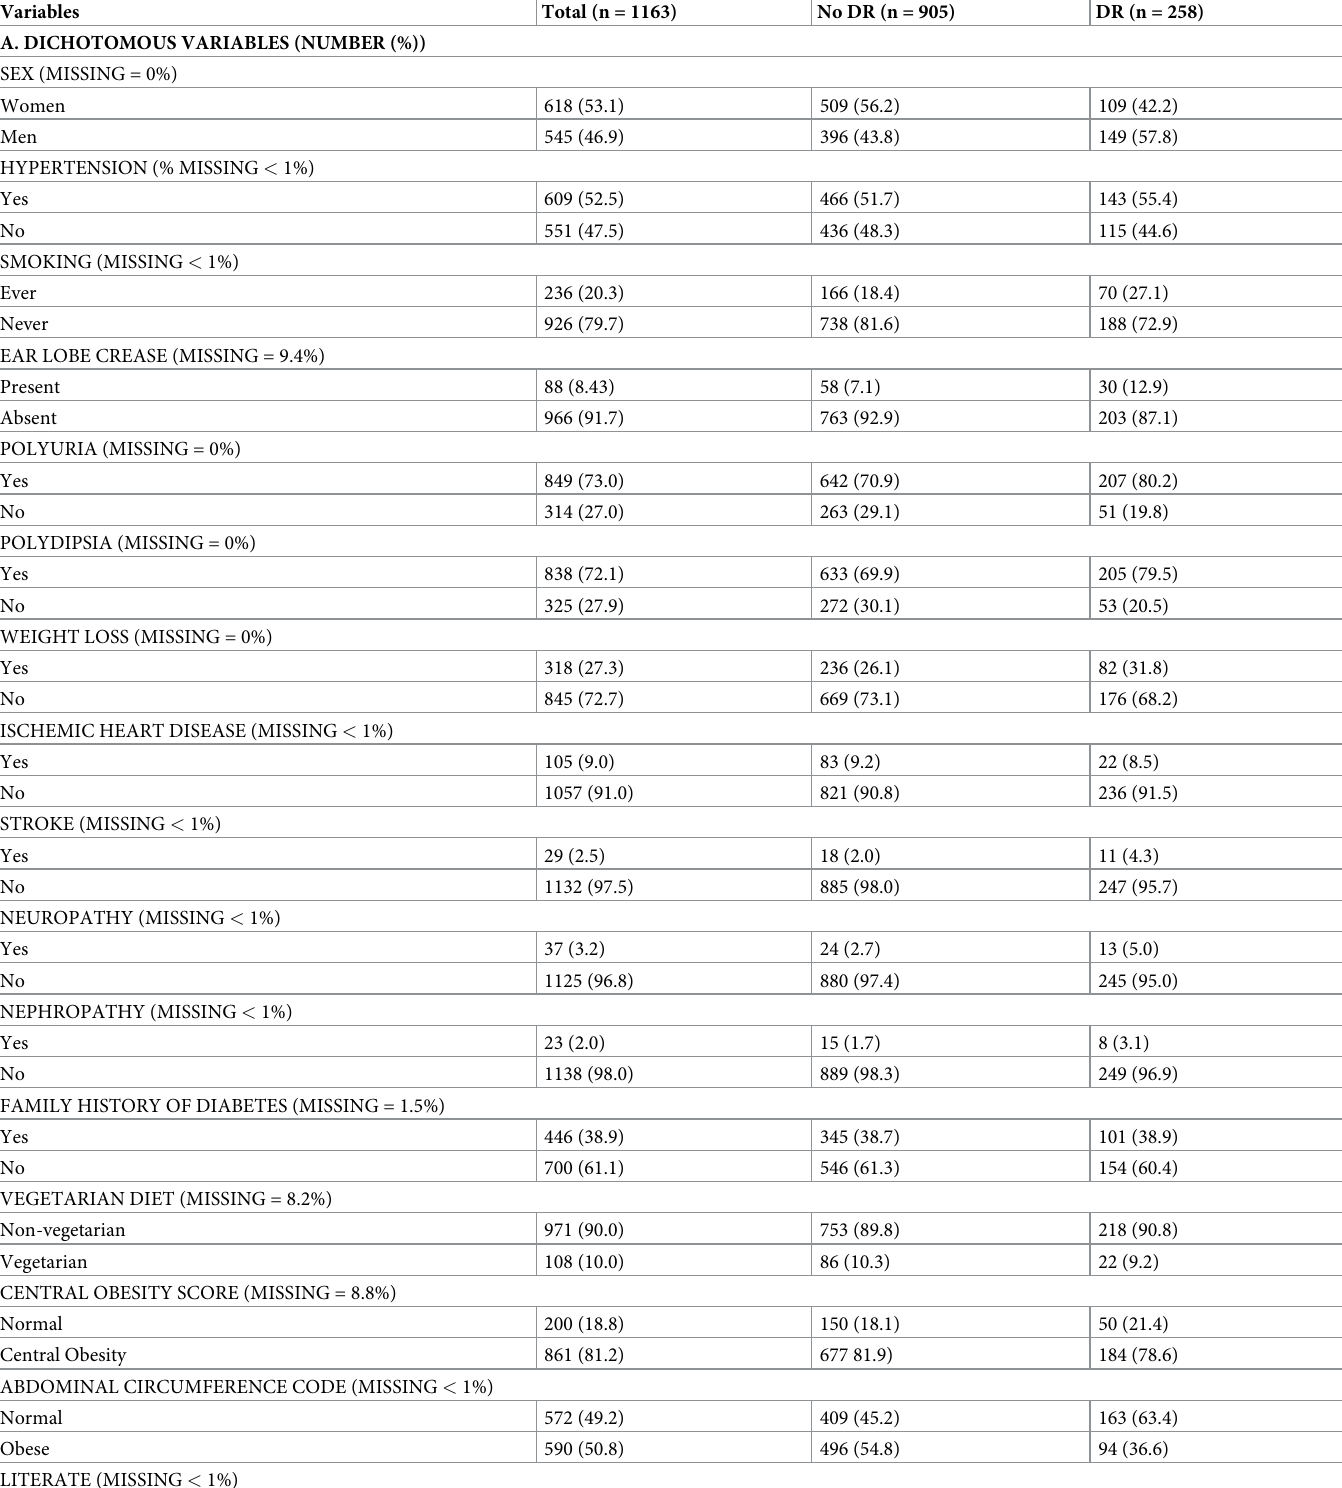
Table 1. Variables included in the